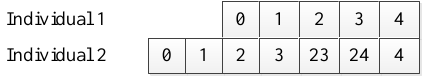
Figure 3. Variable-length real-number coding.